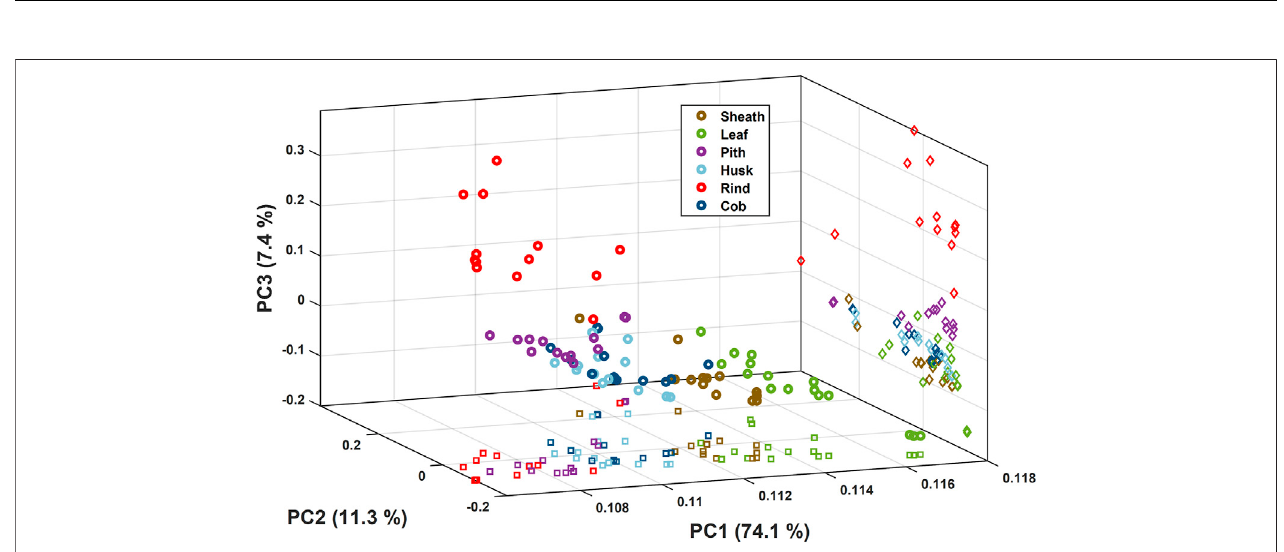
FIGURE 8 | First three principal components of the NIR spectra for pure components of corn stover. Circles represent the position in the 3-dimensional space, squares represent the position in the PC1-PC2 plane and diamonds represent the position in the PC2-PC3 plane.